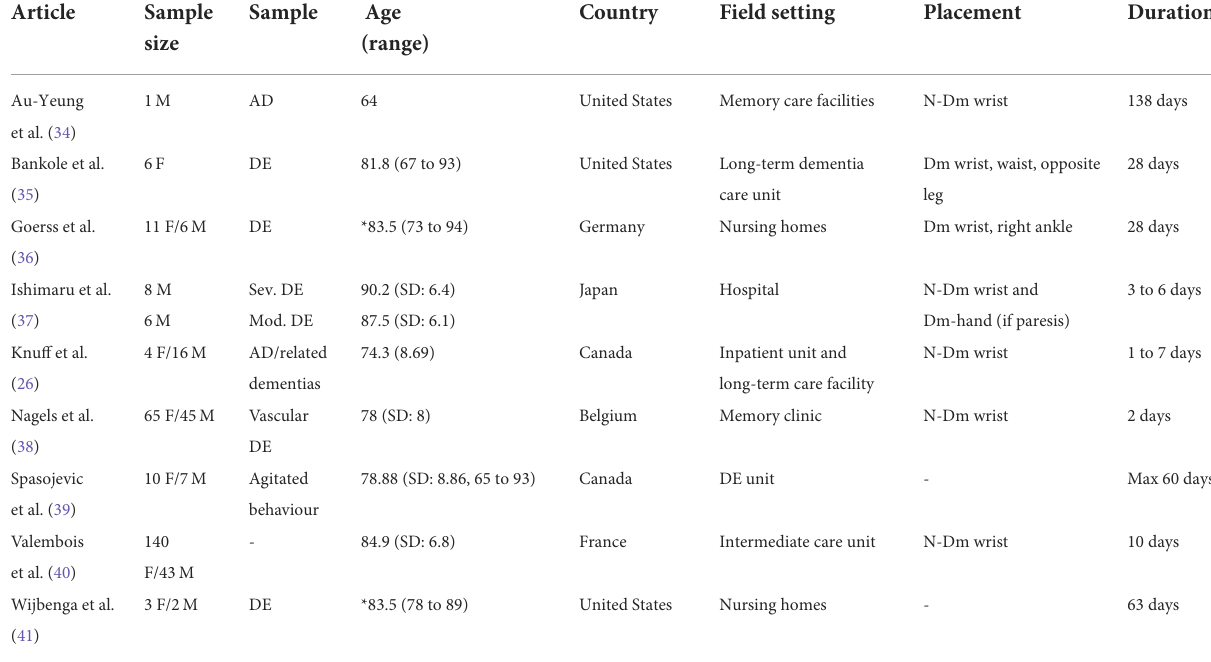
TABLE 1 Basic information on the eligible